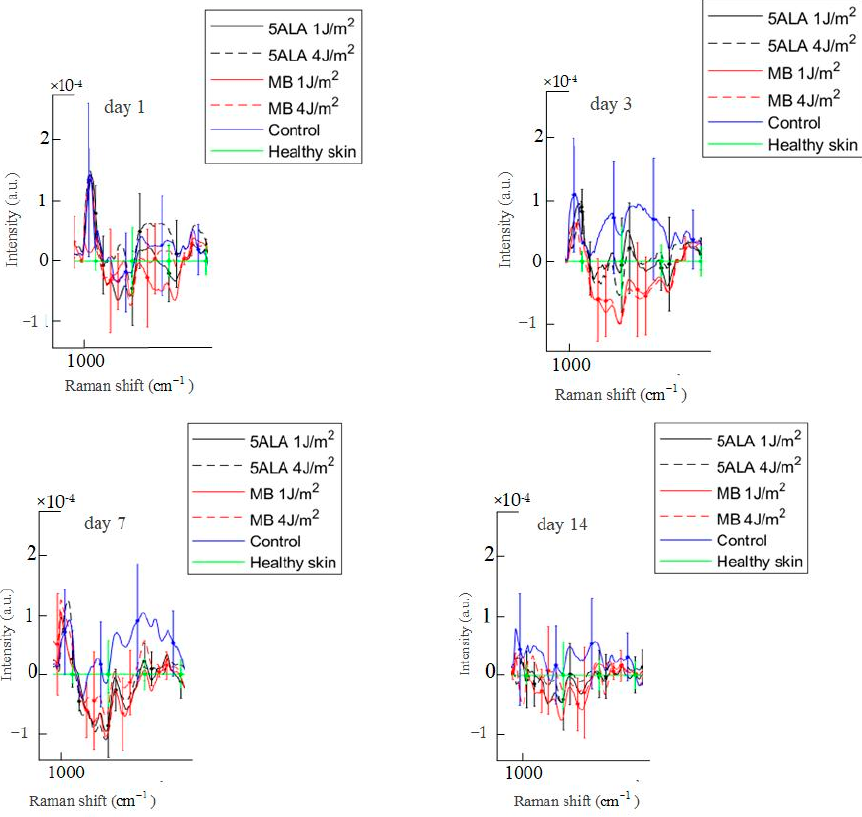
Figure 12. Difference between the wound Raman spectra of all groups subtracting the healthy skin mean Raman spectrum in the 1020–1140 cm − 1 spectral range. The Raman spectra are presented in terms of mean ± StD values. Black line—5ALA 1 J/cm 2 , black dashed line—5ALA 4 J/cm 2 , red line—MB 1 J/cm 2 , red dashed line—MB 4 J/cm 2 , blue line—control, green line—healthy skin (the number of processed Raman spectra was equal to 30 for each group).